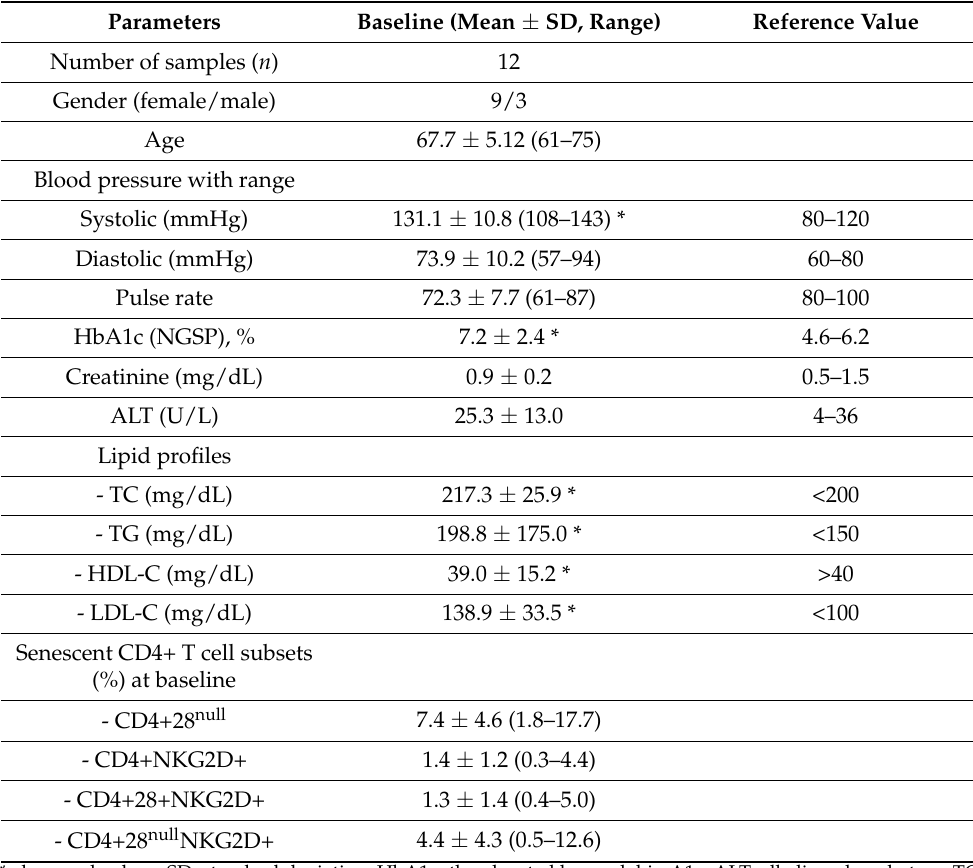
Table 1. Baseline characteristics of